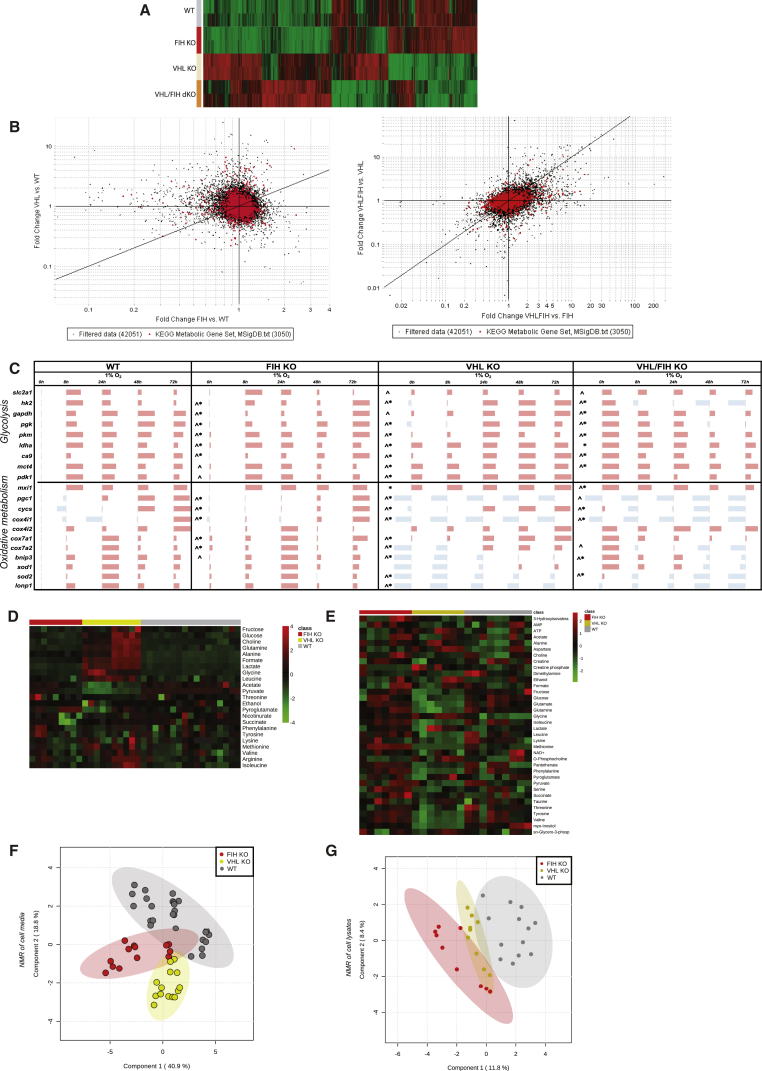
FIH Is a Non-redundant Regulator of Metabolic Parameters and Metabolic Gene Expression(A) Heatmap analysis of microarray data: each row denotes a sample, while each column denotes a gene transcript; net fold changes in gene expression are normalized to column means. Red indicates that a transcript has been significantly upregulated relative to the column mean; green indicates downregulation. A total of 5,000 genes that varied the most with genotype are depicted here.(B) Scatterplot analysis of microarray data: fold change in gene expression that results from acute FIH versus vHL deletion in MEFs. Each data point represents an mRNA transcript. Fold change expression following FIH loss (x axis), and fold change expression following vHL loss (y axis) for the first plot, and the effect of concomitantly knocking out vHL and FIH together compared with single FIH loss (x axis), and compared with single vHL loss (y axis) for the second plot. Genes with metabolic Kyoto Encyclopedia of Genes and Genomes annotations are highlighted in red.(C) qRT-PCR analysis of control MEFs and KO MEFs. Dark red shading indicates an upregulation of the gene transcript relative to control MEFs at 0 hr; light blue shading indicates a downregulation. A two-way ANOVA analysis was performed, to dissect the contributions of genotype and time to expression. ˆ Denotes a significant interaction between time exposed to hypoxia and genotype (p < 0.0001) on gene expression, while ∗ denotes that genotype alone has a significant effect on gene expression (p < 0.0001). The leftmost column in each section reflects genotypic comparisons between normoxic cells, whereas the other data refer to the effect of genotype and indicated duration of hypoxic exposure.(D) Heatmap analysis of 1H-nuclear magnetic resonance (NMR) data. Red indicates that a metabolite has been significantly upregulated relative to the row mean, while green indicates downregulation. Each column denotes an independent cell culture sample. Only aqueous metabolites with the highest absolute abundance are shown.(E) Heatmap of 1H-NMR data performed in MetaboAnalyst: aqueous metabolites in whole MEF lysates.(F) Principal component analysis (PCA) of 1H-NMR data performed in MetaboAnalyst: each data point denotes an independent cell culture media sample. Each genotype is demarcated by a 95% confidence interval (oval).(G) PCA of 1H-NMR data performed in MetaboAnalyst: each data point denotes an independent sample of whole-cell lysates.See also Figure S1.